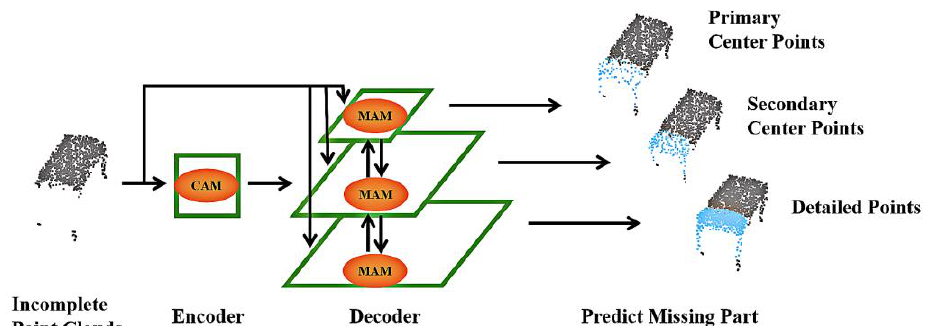
Figure 1. Our method directly predicts missing point clouds (blue points) with incomplete point clouds (gray points) as input. We designed an encoder–decoder architecture with a Channelwise Attention Module (CAM) and a Mixed Attention Module (MAM). The decoder utilizes a bidirectional point pyramid attention network and skip connections to generate multiscale predictions (primary center points, secondary center points, detailed points).